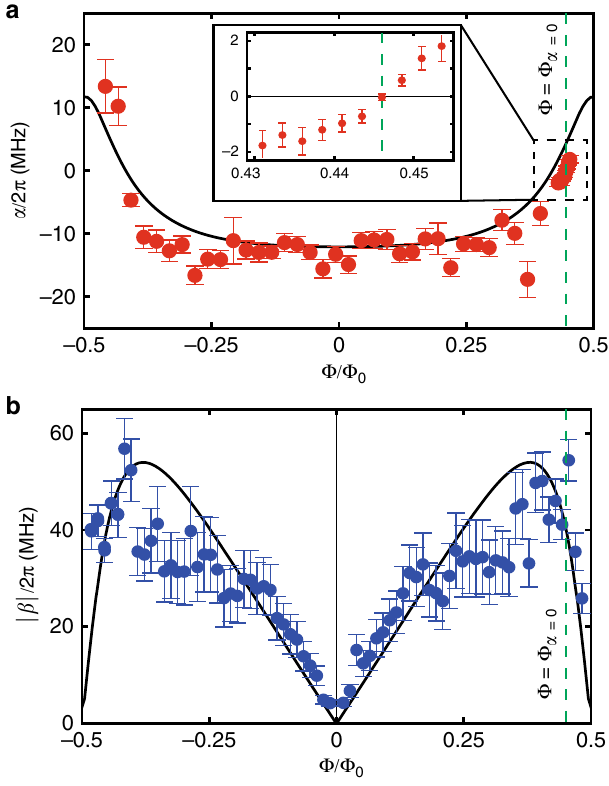
Fig. 2 Nonlinearity of the MW resonator. a Self-Kerr nonlinearity α as a function of the fl ux through the SNAIL loop. Inset shows an enlarged view around Φ = Φ α = 0 . b Absolute value of the Pockels nonlinearity ∣ β ∣ , obtained from the phonon-to-photon conversion experiment, as a function of the magnetic fl ux bias. The curve in each panel shows the result of the numerical simulation without any fi tting parameters. Green dashed lines indicate Φ = 0.445 Φ 0 ≡ Φ α = 0 . The theoretical curves are the same as those in Fig. 1f. Error bars represent standard